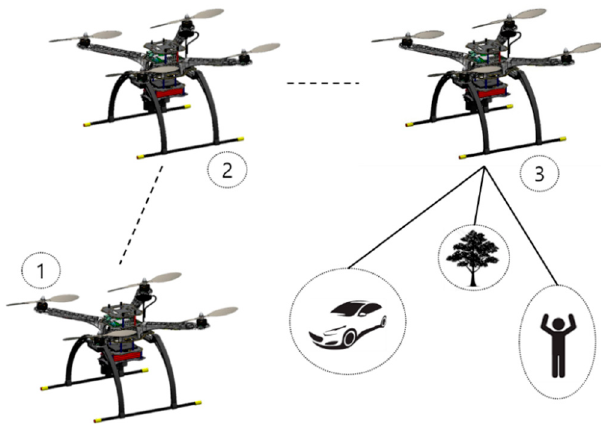
Figure 4. The portrayal of the aerial vehicle looking for a target with a drone taking off from the ground, following a designated waypoint, and looking for objects.